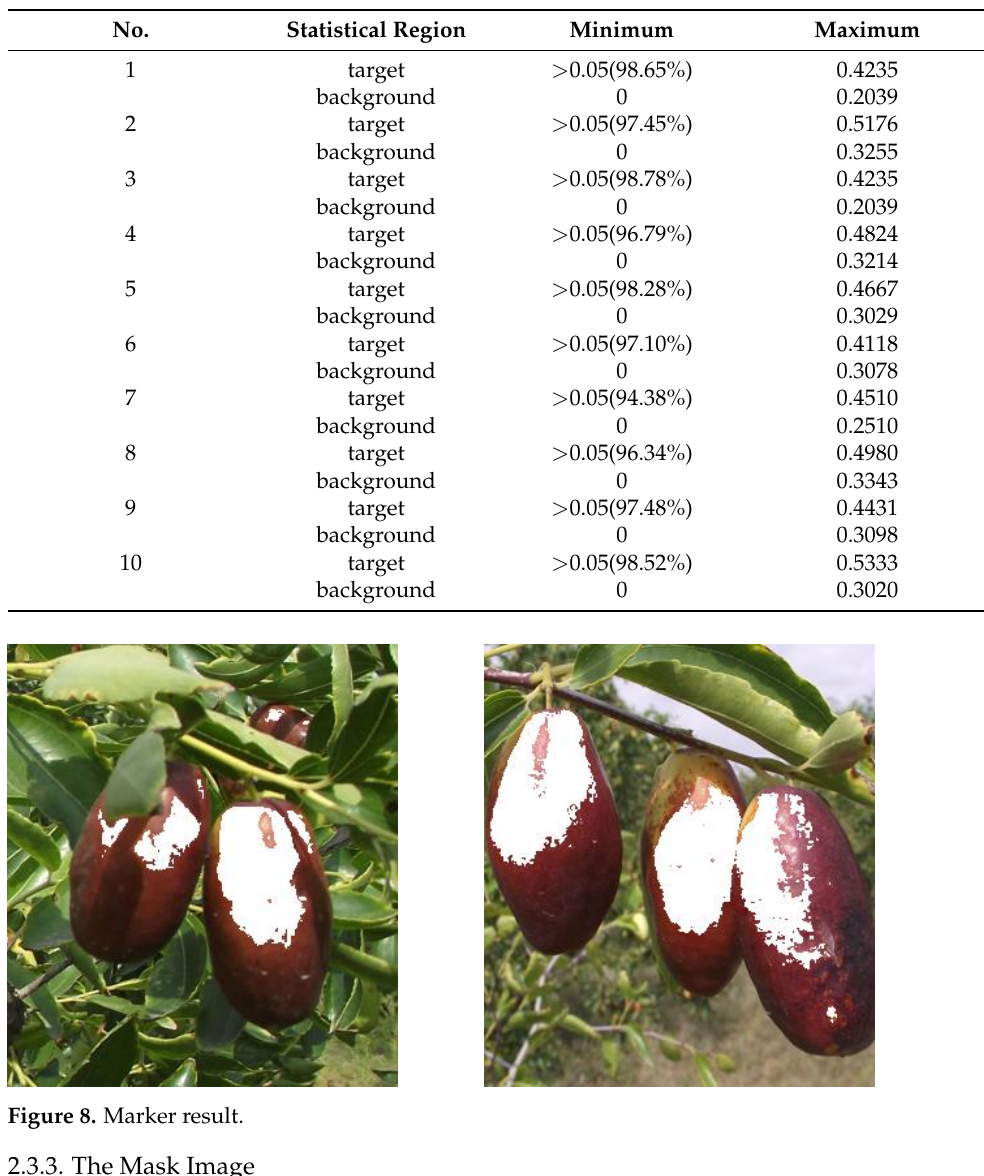
Table 1. Statistical results.